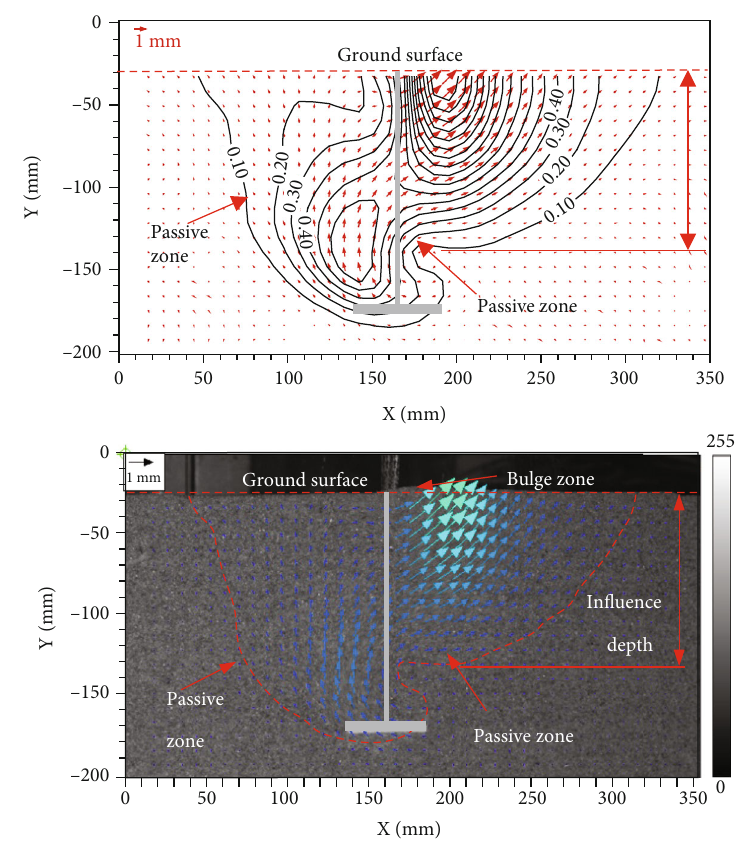
Figure 12: Displacement fi eld at the ultimate load for D